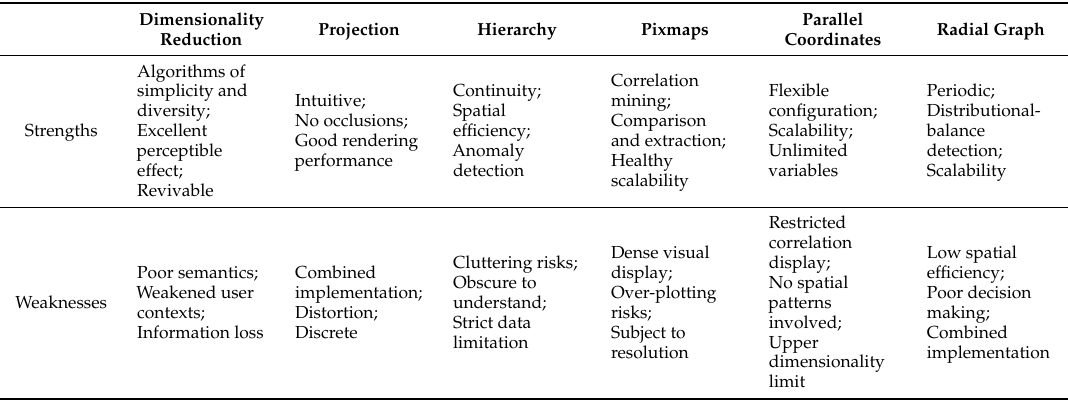
Table 3. Overview comparing strengths and weaknesses of high-dimensional visualization techniques. Dimensionality Reduction Projection Hierarchy Pixmaps